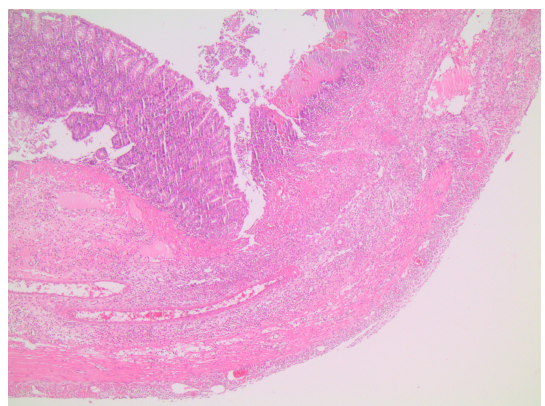
Figure 3. TNBS group on day 3, intact and necrotic mucosa areas, transmural inflammation, edema, and congestion (H&E, × 40). H&E, hematoxylin and eosin; TNBS, trinitrobenzene sulphonic acid.